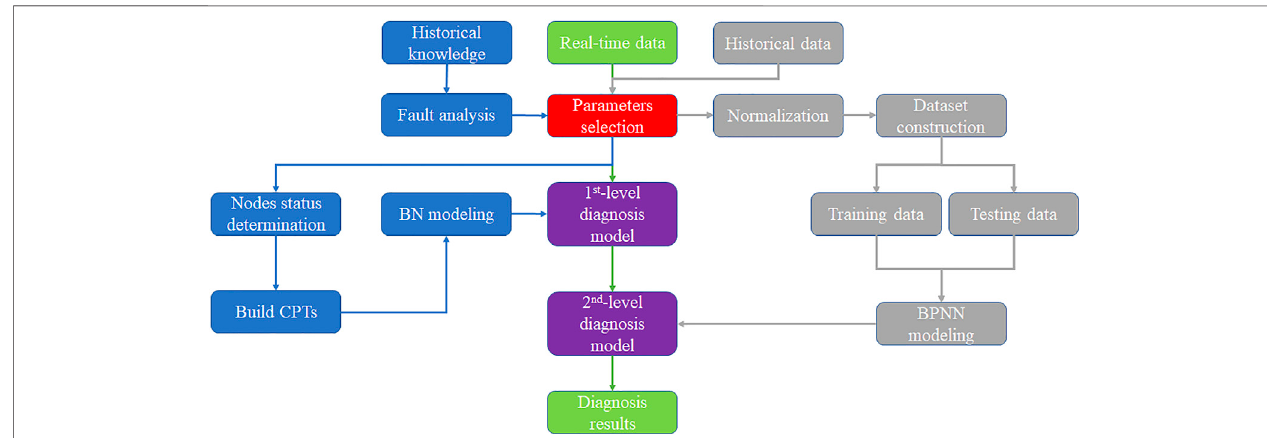
FIGURE 5 | SBN-ANN fault diagnosis